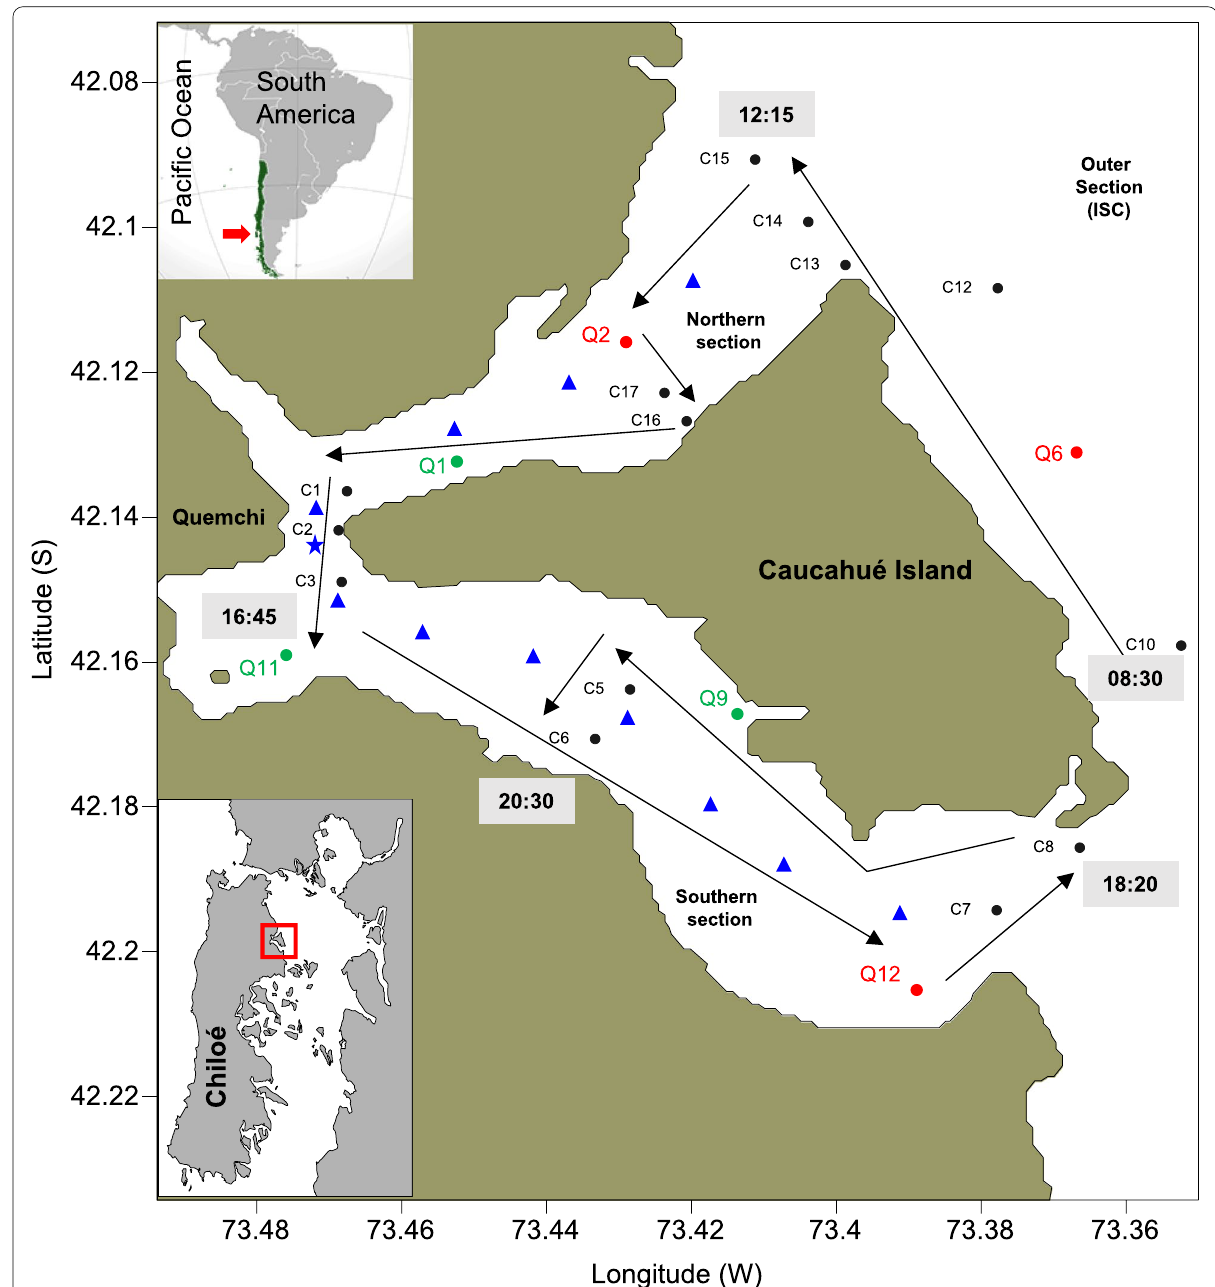
Fig. 1 The Caucahué Channel. Sampling sites (circles), sampling track (black arrows) and approximate time of zooplankton sampling on June 19. Q sites are near aquaculture centers (green mytilids, red salmonids) and C sites are far from aquaculture centers. The zooplankton sampling track = = begins at site C10 (08:30 h) and ends at site C6 (20:30 h). Blue triangles indicate CTDO sampling sites on June 30. The blue star indicates the